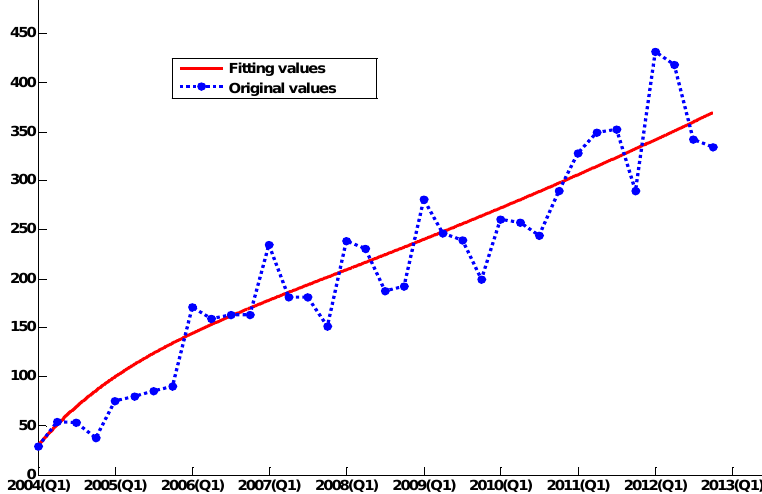
Figure 5. The comparison between real values and the simulation values.